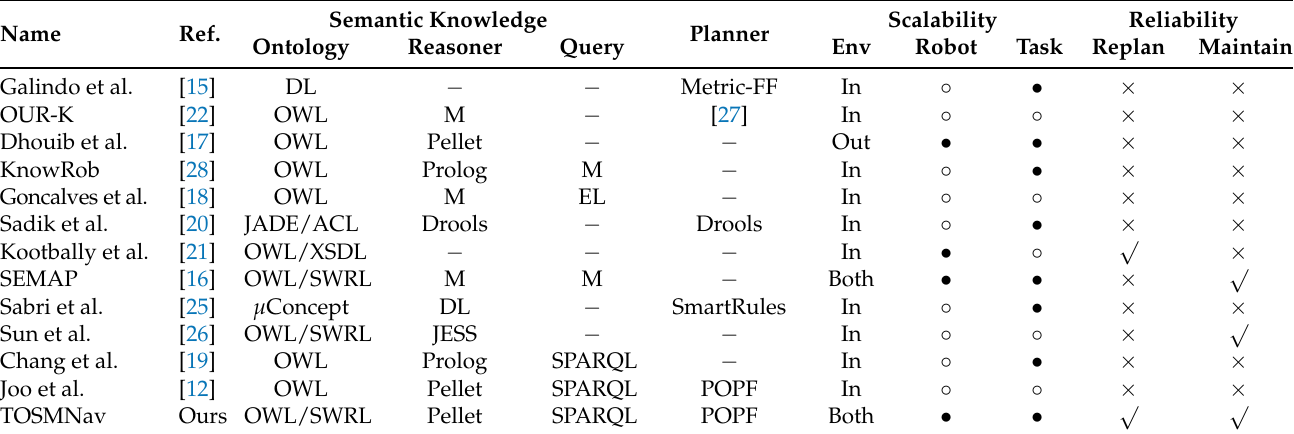
Table 1. Comparison for semantic navigation